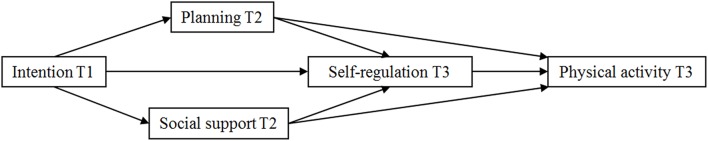
Hypothesized mediation model.